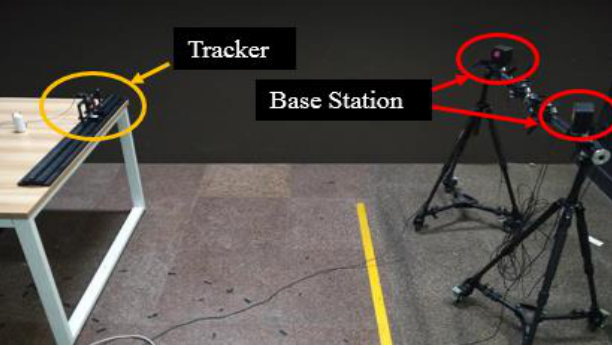
Figure 6. Precision test experimental environment.